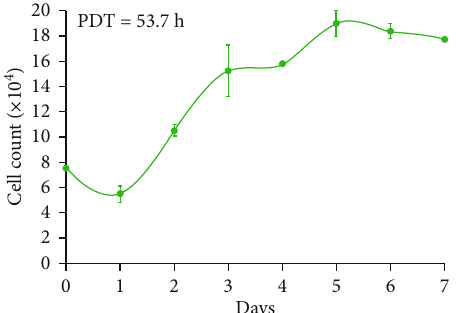
Figure 4: Mean and standard error of cell counts in growth curves of rabbit bone marrow-derived mesenchymal stromal cells, passage 3. PDT: population-doubling time. It should be noted that the samples are technical